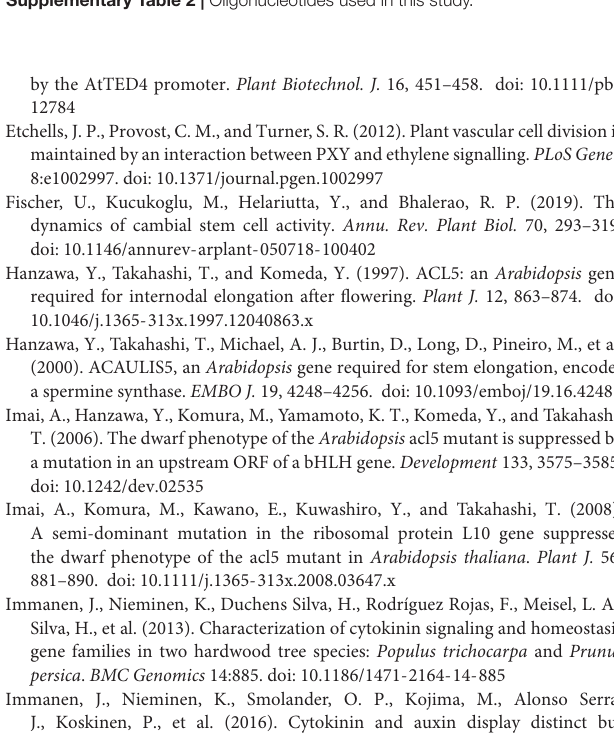
Supplementary Figure 1 | SAC51 homologs in Populus . Supplementary Figure 2 | Biseriate ray cells phenotype. Supplementary Figure 3 | Relative expression of ACAULIS5 in 35S : POPACAULIS5 and p COMT:PttACL5 transgenic lines tissues. Supplementary Figure 4 | GUS activity in TCSn:GUS transgenic lines in the POPACAULIS5 tree background. Supplementary Table 1 | Complete list of cytokinin levels in wild type and 35S:POPACAULIS5 and p COMT:PttACL5 transgenic lines. Supplementary Table 2 | Oligonucleotides used in this